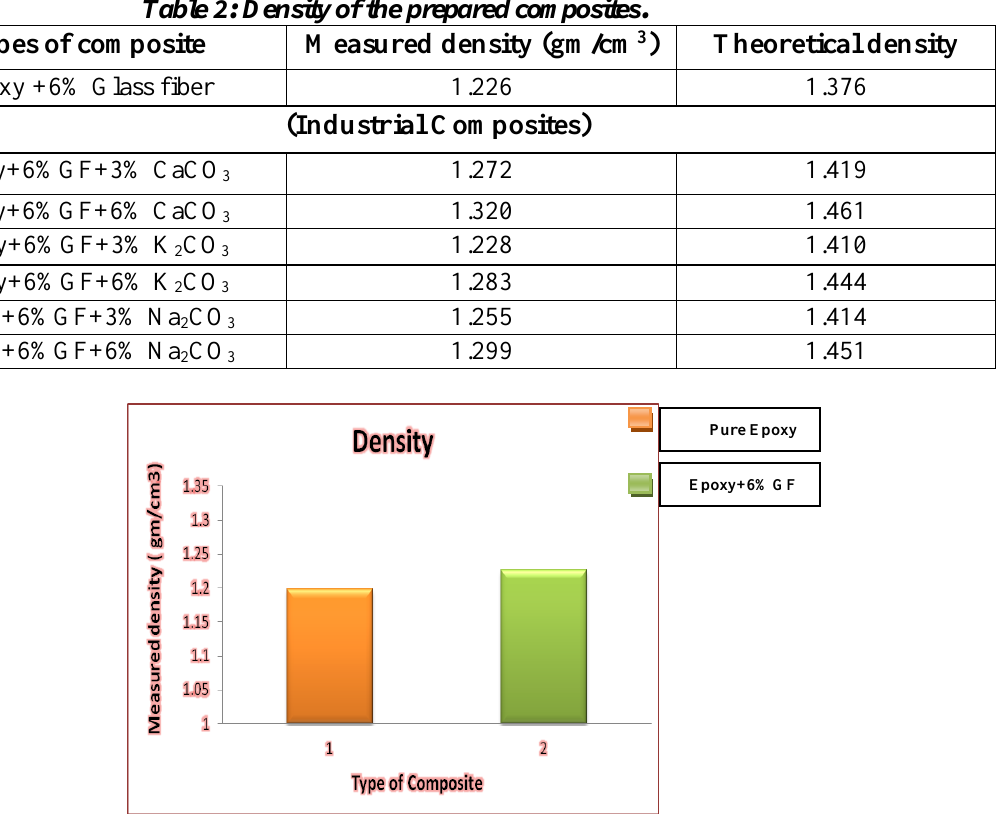
Fig.6: Measured density of Epoxy +6% glass fiber composites and pure